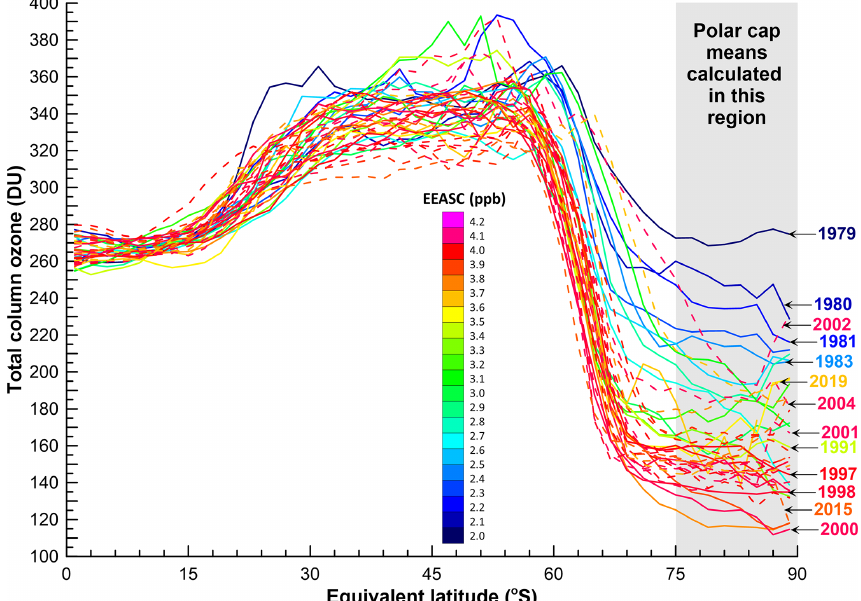
Figure 6. Zonal mean TCO profiles by equivalent latitude calculated on the 550K surface for 1 October of each year. Each trace is coloured by equivalent effective Antarctic stratospheric chlorine (EEASC) shown in the colour-scale insert in the figure. Solid lines show data for the period 1979–2000, while dashed lines show data for the period thereafter. Uncertainties have been excluded from these traces for clarity but are generally very small (i.e. less than 5DU at this time of the